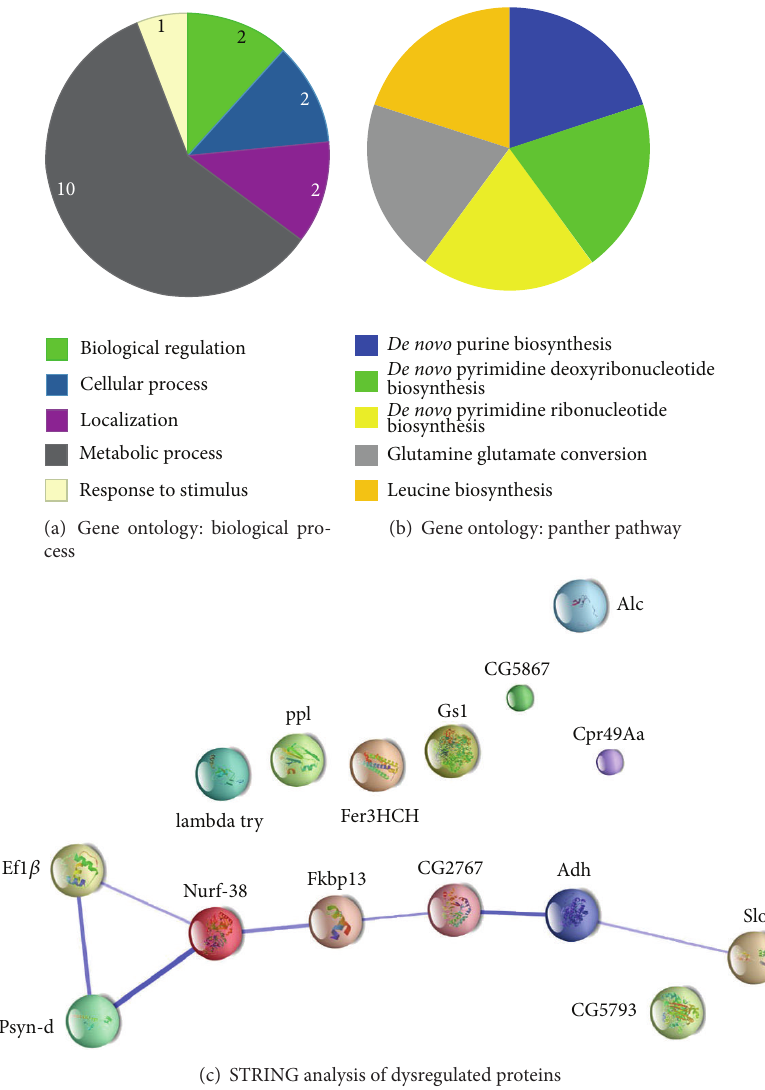
Figure 7: Gene ontology and interacting gene analysis for 22 dysregulated proteins in DTor mutant brains. (a-b) Twenty-two dysregulated proteins were allocated according to their biological processes (a) or pathways (b). Protein-protein interactions among them were predicted using STRING DB (c). The size of each node is correlated with the amount of structural information associated with each protein. The width of lines represents the confidence score of precalculated protein-protein interaction [16,